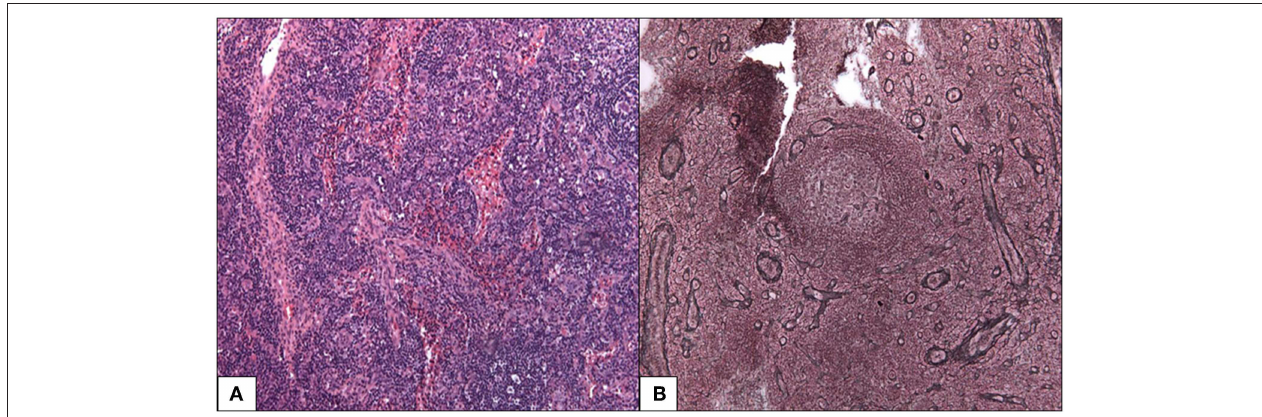
FIGURE 1 | Mixed histopathological subtype of Castleman disease. (A) Follicles are characterized by an atrophic germinal center with few lymphocytes, radially penetrated by blood vessels (lollipop follicle). HES 100x (B) the small lymphocytes of the mantle zones are arranged in concentric rings around the germinal center. Silver impregnation after Gordon-Sweet